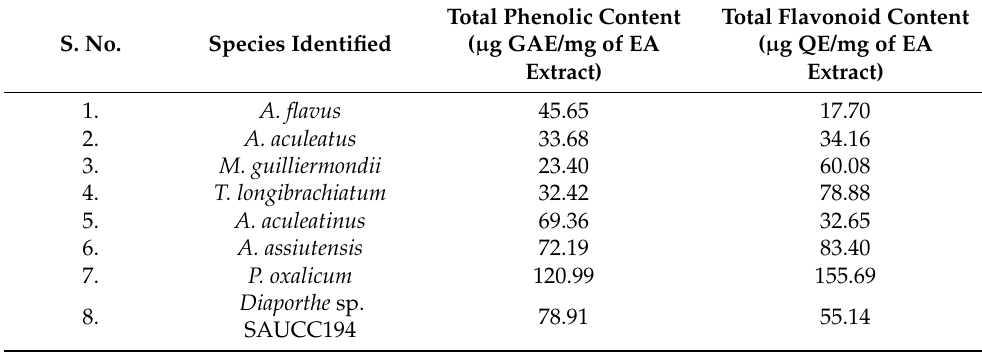
Table 1. Total phenolic content and flavonoid content present in EA extract of identified fungal strains associated with the leaf of A. rohituka